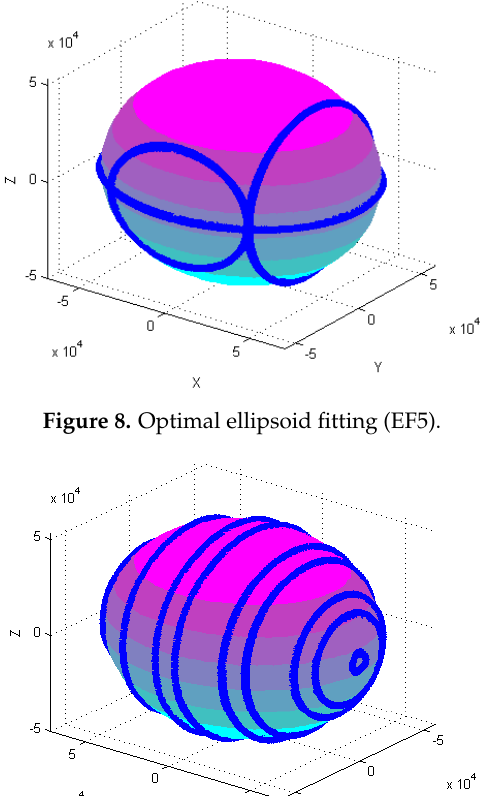
Figure 9. Optimal ellipsoid fitting (EF6).